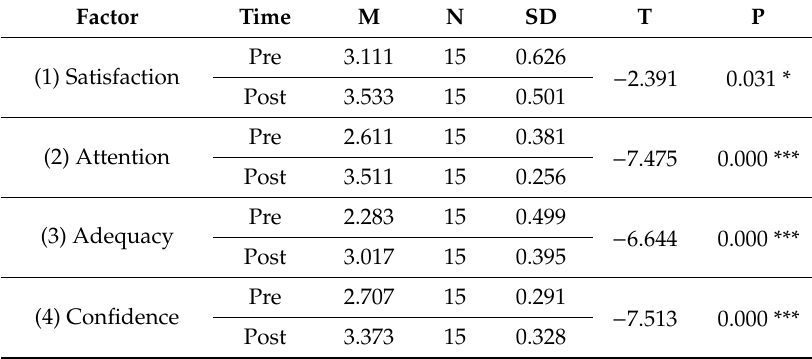
Table 11. Analysis result of di ff erence between pre- and post-scoring incentives of Experimental control